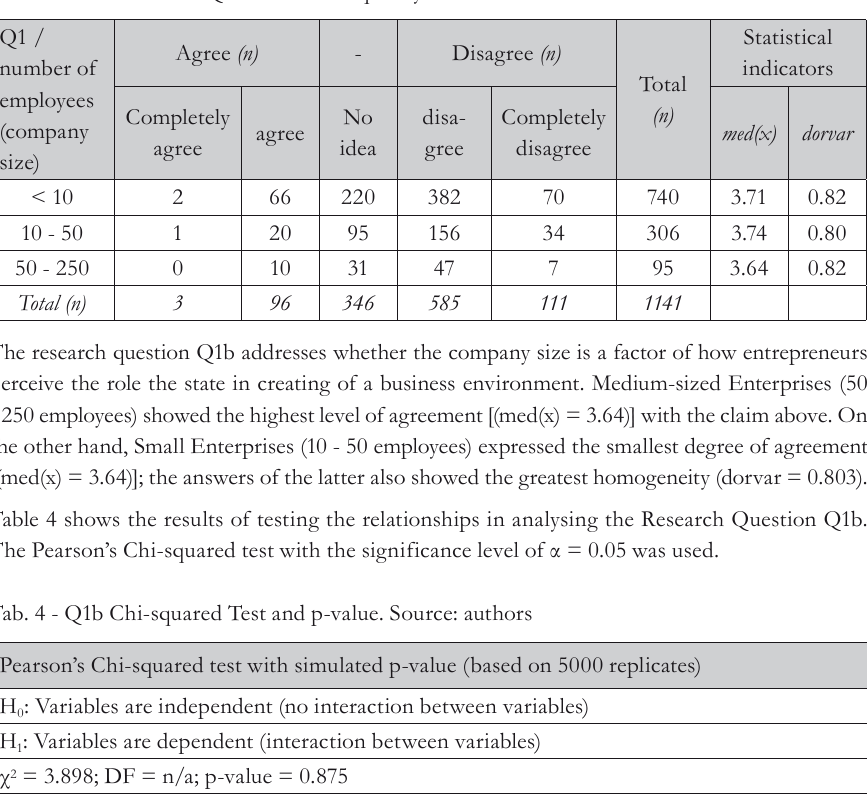
Tab. 3 – Pivot table for Q1b absolute frequency and Statistical characteristics. Source: authors